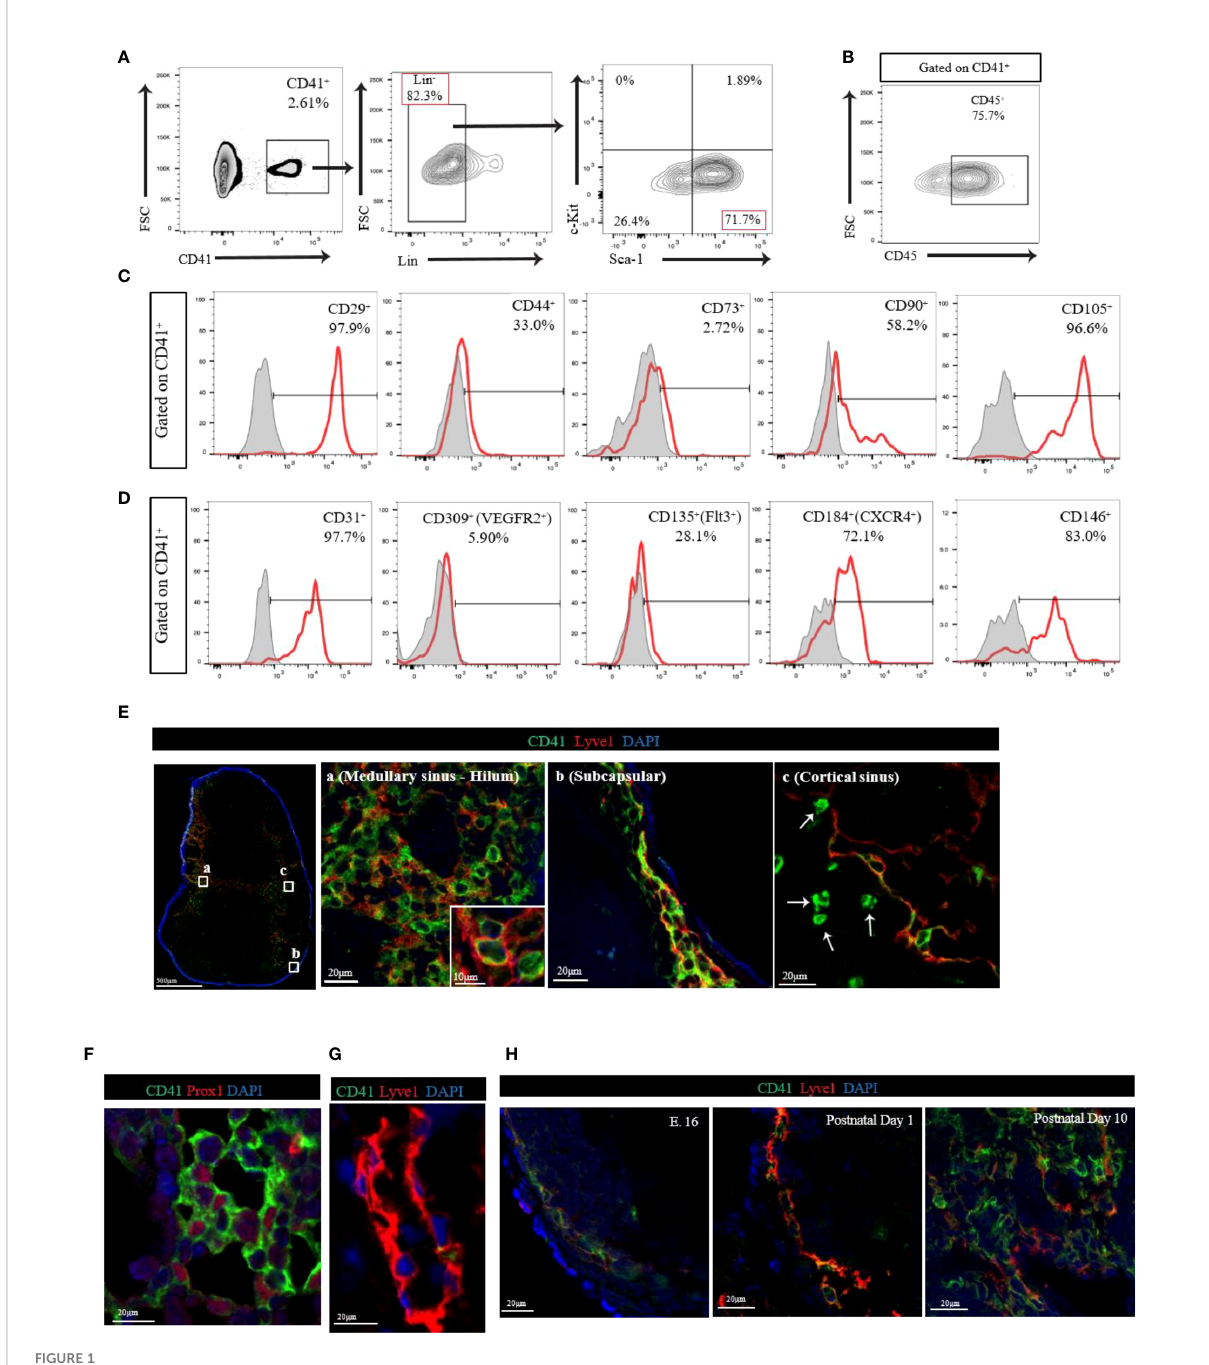
FIGURE 1 (A) Flow cytometry analysis of CD41 + Lin - cells from LN. The vast majority of CD41 + Lin - cells showed positive for Sca-1, but negative for c-Kit in LN. (B) Flow cytometry analysis of CD41 + cells from LN showed high expression of CD45. (C) Histogram images of mesodermal stromal cell markers in LNs. High expression of stromal markers, including CD29, CD44, CD90 and CD105, was observed in CD41 + cells (representative image from 3 individual experiments). (D) Histogram images of the endothelial/progenitor cell markers in LNs showed high expression of CD31, CD184 and CD146, and moderate expression of CD135 in CD41 + cells (representative image from 3 individual experiments). (E) Confocal images in different segments of lymphatic vasculature within the naïve C57BL/6 mouse axillary LN. The vast majority of Lyve1 + cells co-expressed CD41 in medullary sinus-hilum (a) and subcapsular (b). CD41 + Lyve1 - cells were also found in cortical sinus (c) . CD41 (green), Lyve1 (red) and DAPI (blue). (F) Co-staining of CD41 and PROX1 in naïve LN. (G) The thoracic duct from a naïve C57BL/6 mouse expresses Lyve1 but lacks CD41 co- expression. (H) IF micrograph of LNs of E.16 showed expression of CD41 in conjunction with Lyve1 expression. Both postnatal day 1 and day 10 showed also co-expression of Lyve1 and CD41 but with an increase in overall expression of Lyve1 in day 10